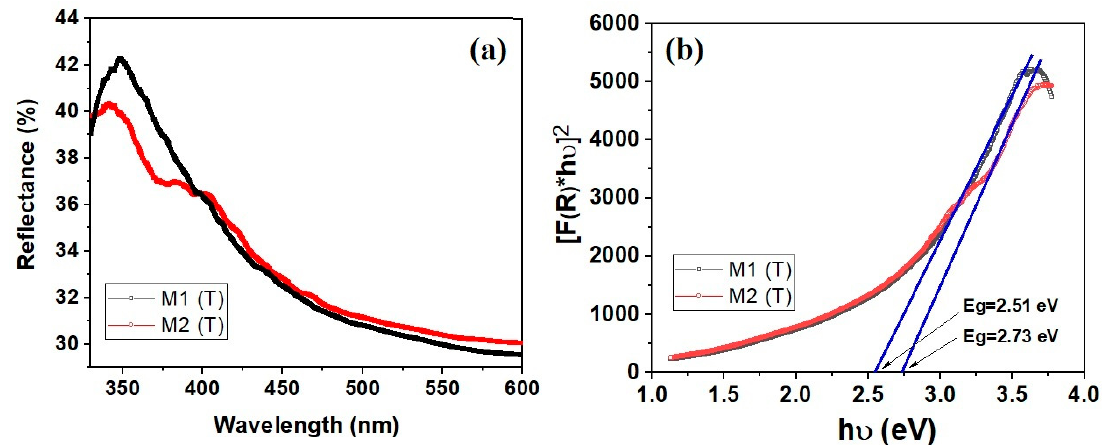
Figure 6. Optical properties of carbon/ZnO nanostructures ( a ) diffuse reflectance ultraviolet–visible (UV–Vis) spectra and ( b ) plot of [ F(R)h ν ] 2 versus h ν and band gap determination.